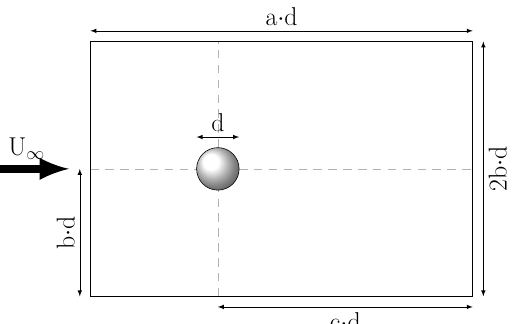
Figure 5. Horizontal cross-section of the size equivalent sphere cases. Cuts through all Cartesian axis planes look identical. The scaling factors of the simulation domain are a = 23, b = 8, c =